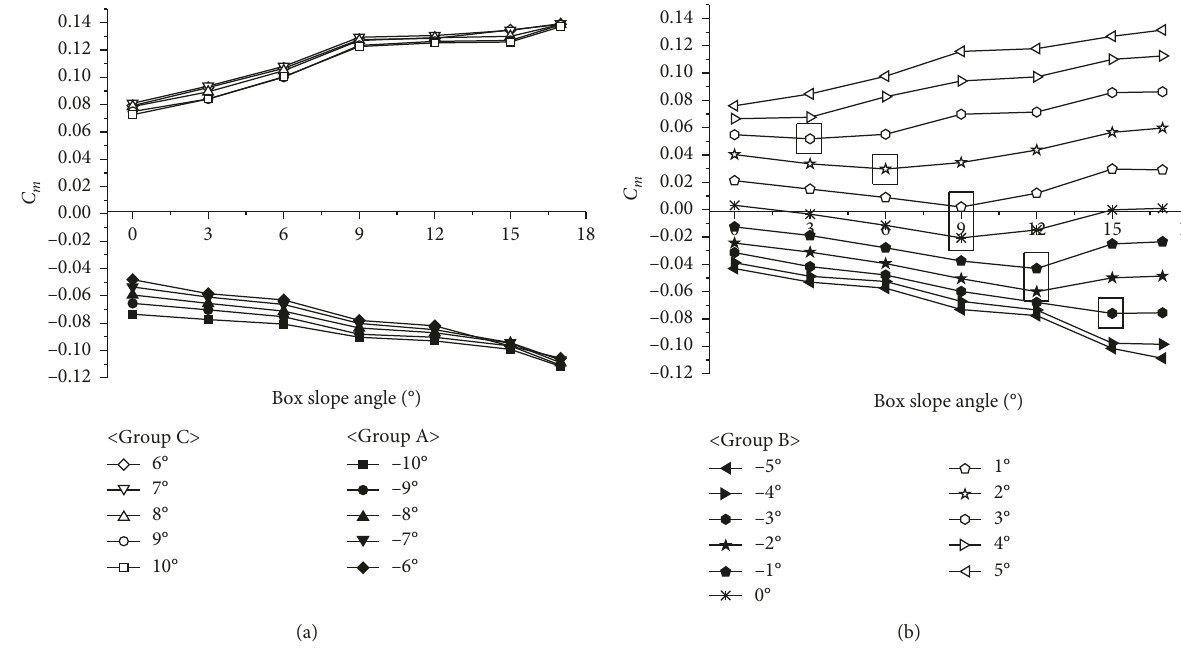
Figure 18: C m vs. box slope angle for various AOA: (a) groups A and C; (b) group